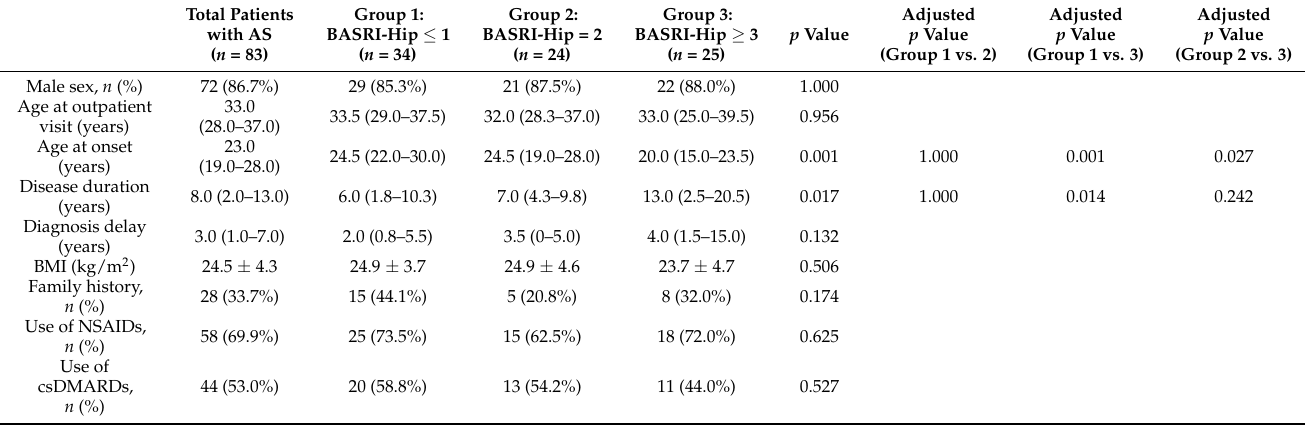
Table 1. Comparison of demographic data among patients with ankylosing spondylitis, based on the degree of hip involvement.